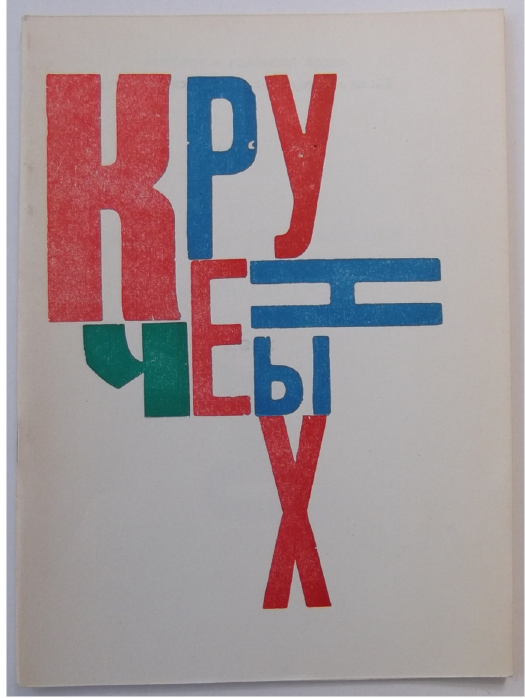
Figure 10. Cover of ‘Arabeski iz Gogolia’.